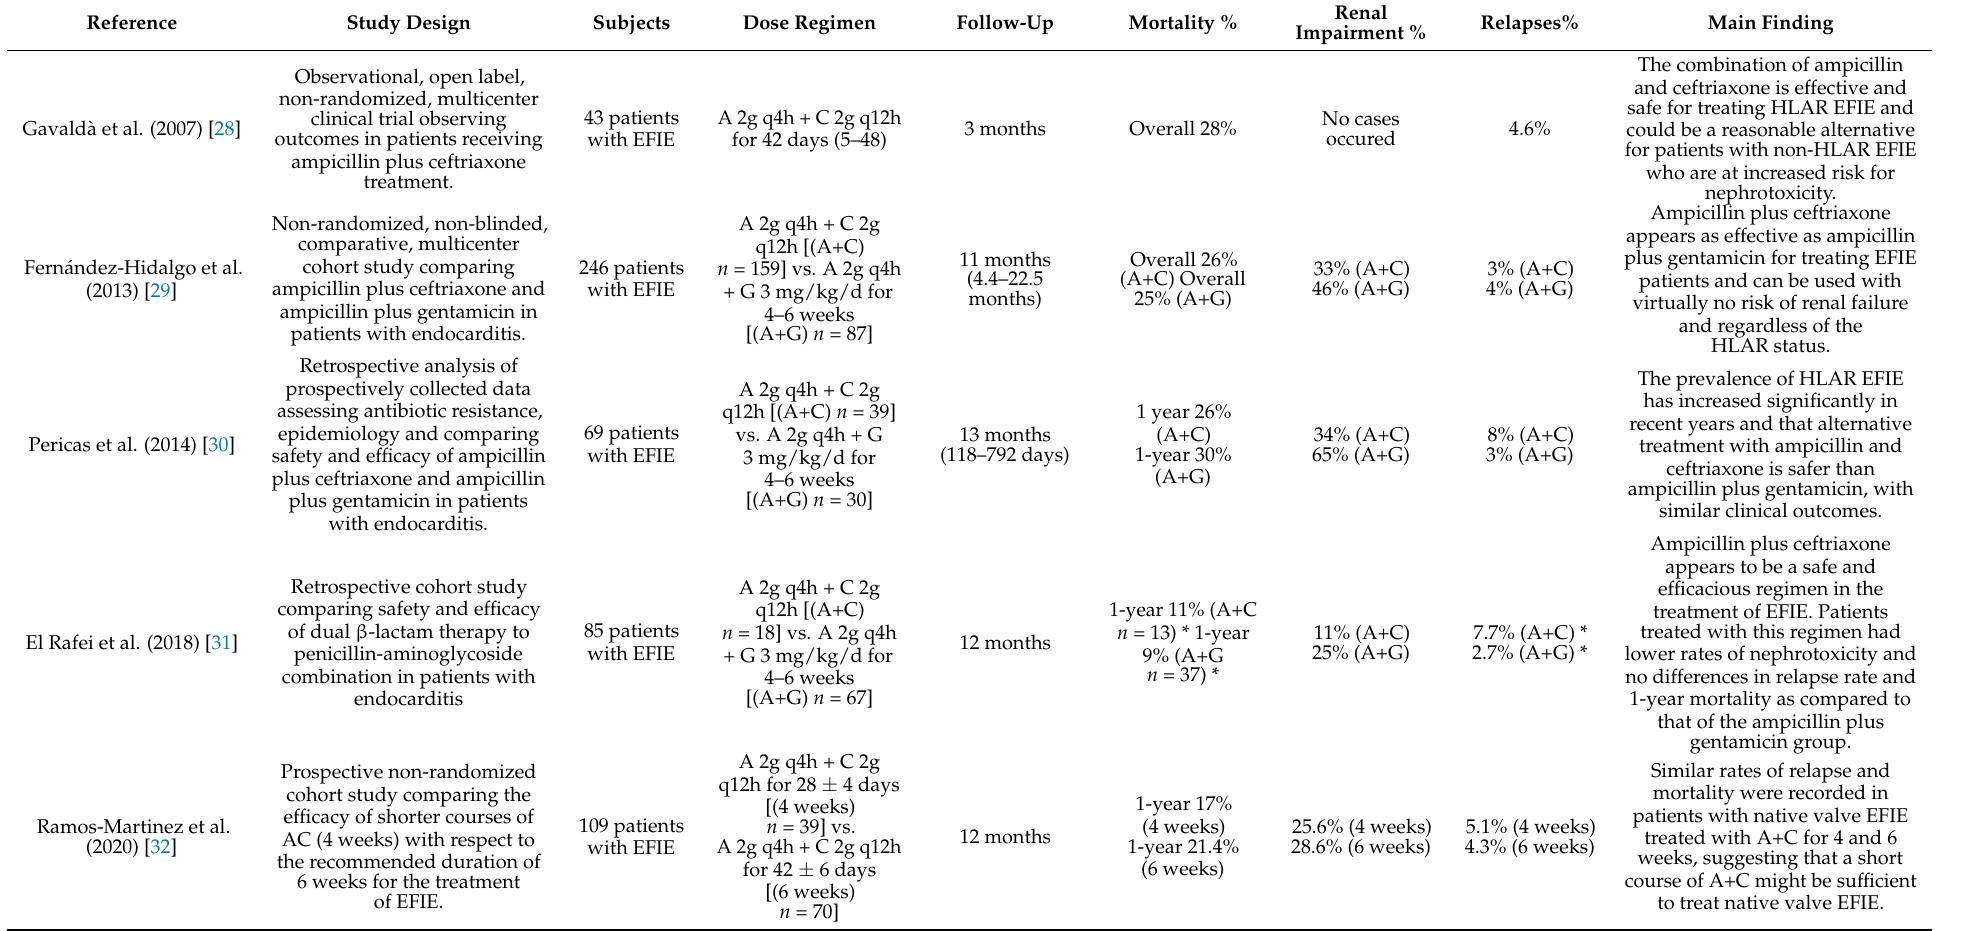
Table 1. Clinical data evaluating dual beta-lactam combination therapy in EFIE treatment (A = ampicillin; C = ceftriaxone; G = gentamicin; * = completed